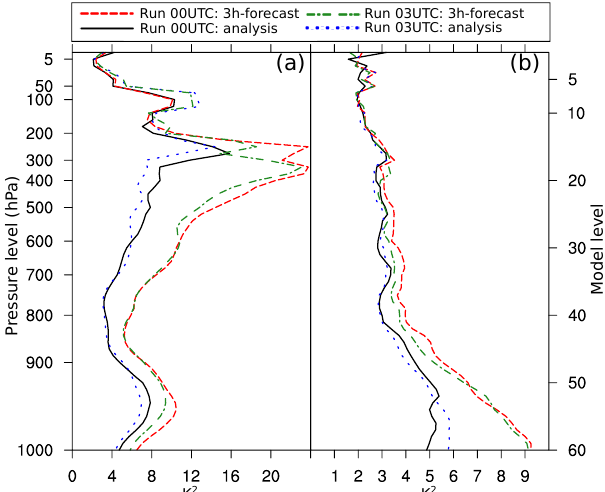
Figure 7. Vertical profiles of K 2 on background and analysis er- rors for (a) q and (b) T , for two successive cycled assimilation/3h forecast steps starting at 00:00UTC on 4 November